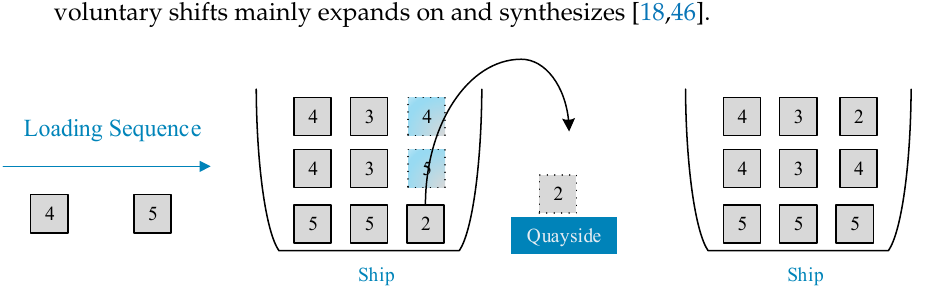
Figure 2. Example of container relocation in the yard.